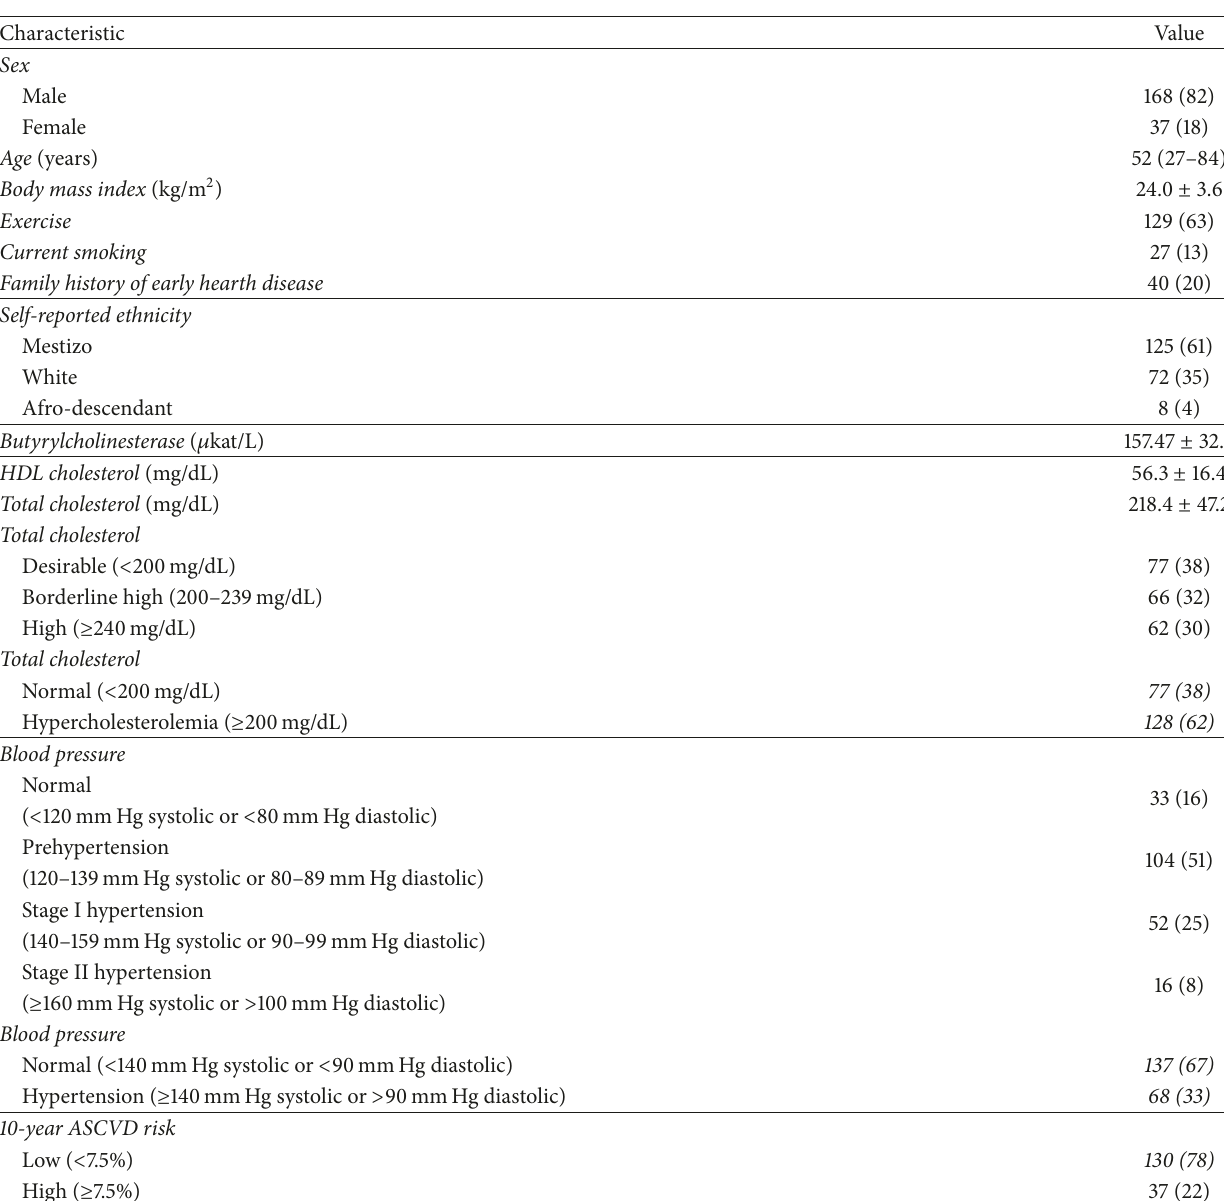
Table 1: Demographic characteristics and laboratory profile of the study population ( 𝑛 =